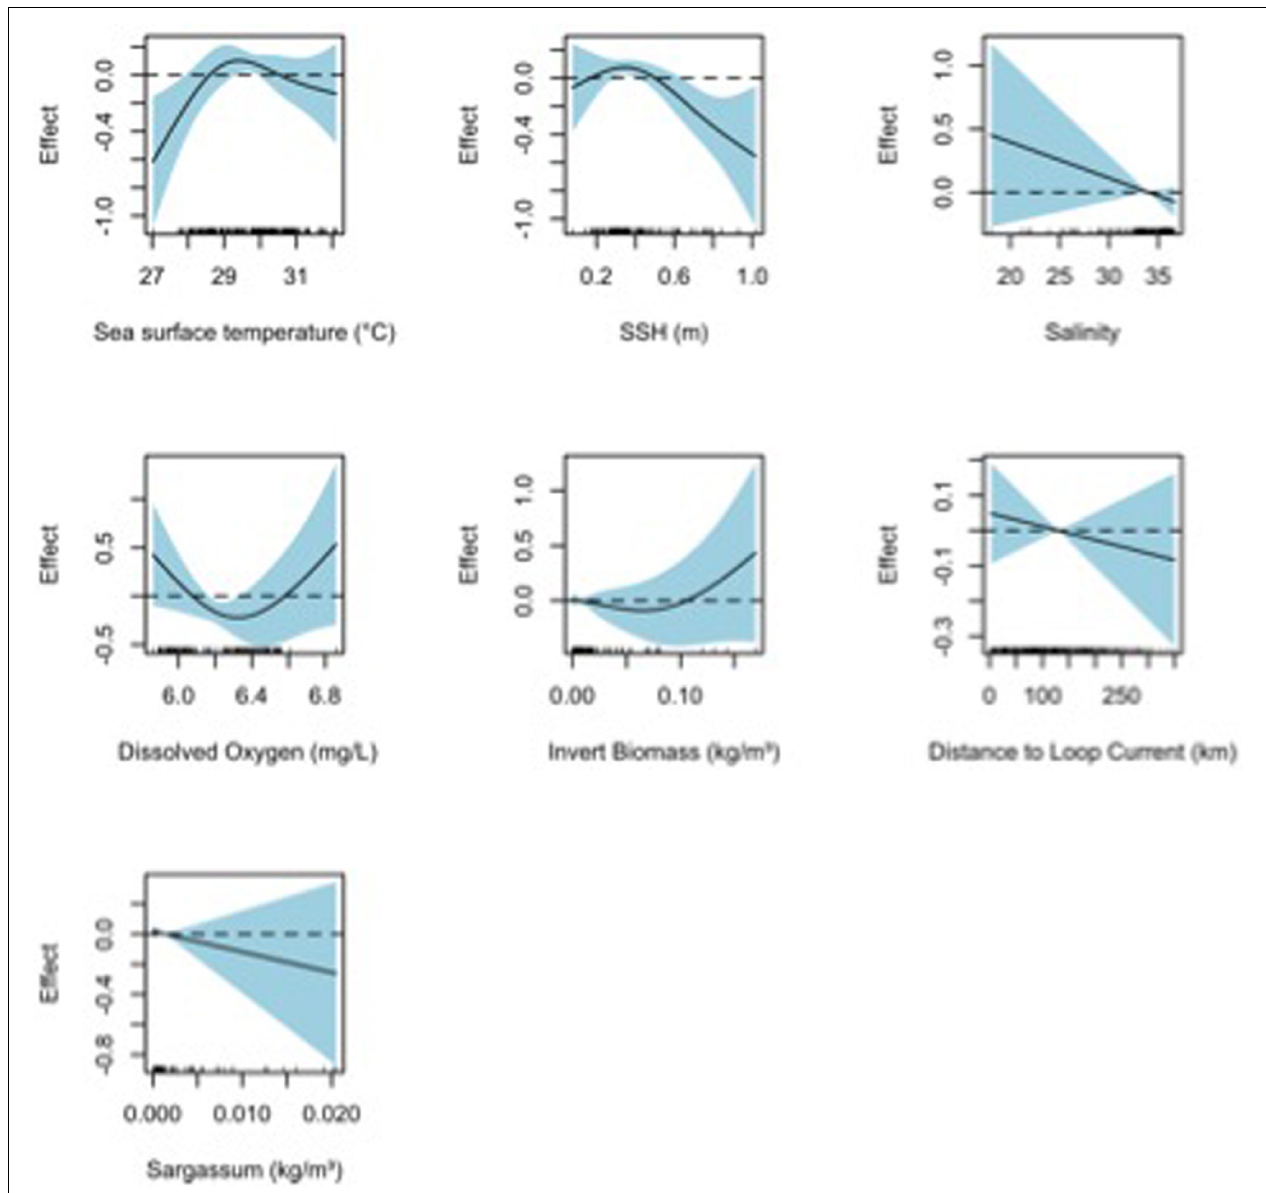
FIGURE 5 | Response plots for 2015 oceanographic variable of the surface sample (0–1 m with neuston tows) Shannon diversity ( H’ ) from full generalized additive model (GAM). Plots include sea surface temperature ( ◦ C), sea surface height (m), salinity, dissolved oxygen (mg L − 1 ), invertebrate biomass (kg m − 3 ), distance to Loop Current (km), and Sargassum density (kg m − 3 ). Solid lines represent smoothed values and the shaded area represents 95% confidence intervals. Dashed line displayed at y = 0 on response